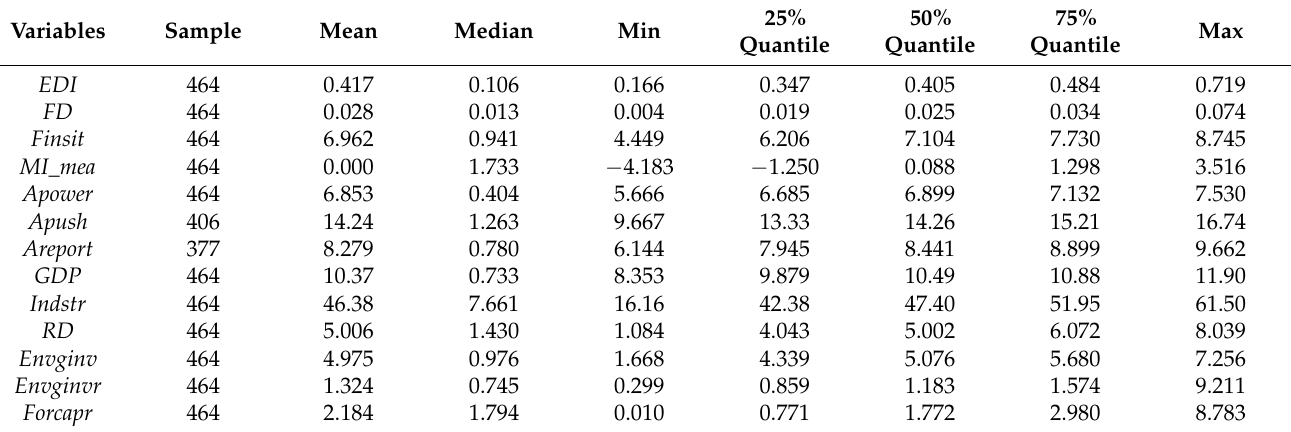
Table 3. Descriptive